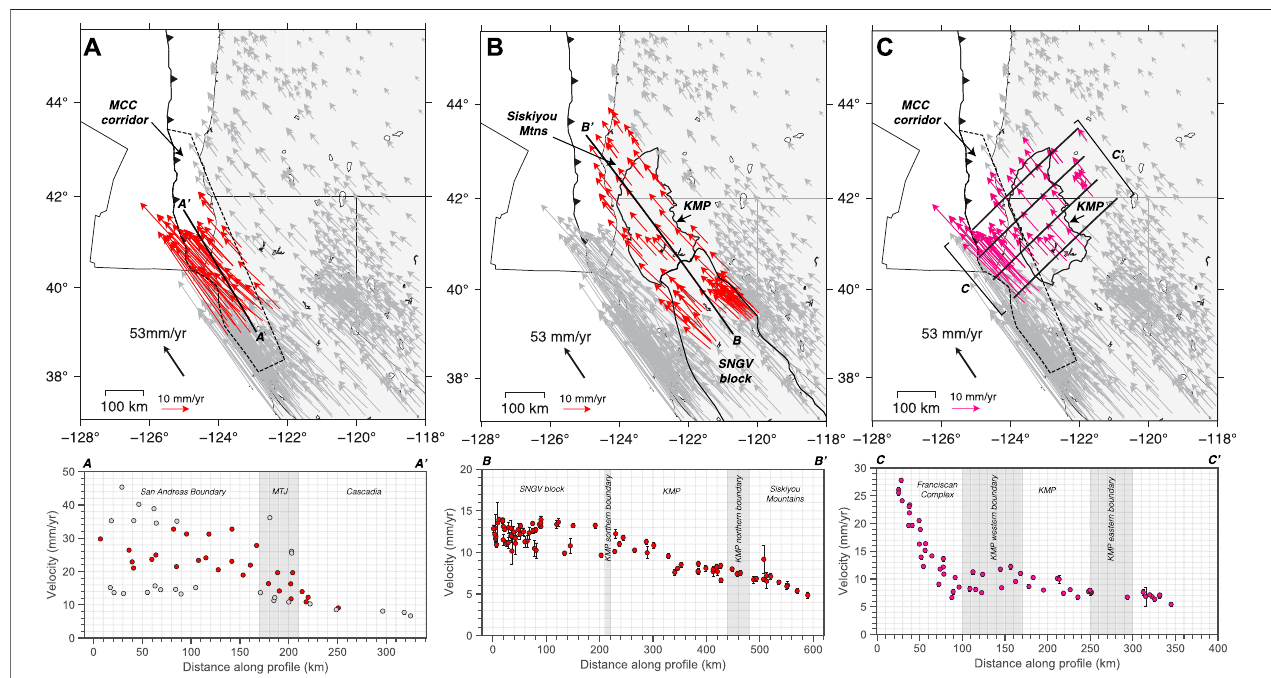
FIGURE5| Transectsthroughthepresent-dayNNW-directedandsubduction-relatedGPSdecomposedvelocity fi elds. (A) NNWtransect(southtonorth)through the NNW-directed velocity fi eldwithin theMCC corridor – theFranciscan complexwestofthe KMP.Red vectors withinthe map (top)are thevelocities(bothgrey and red circles) shown in the pro fi le (bottom). The grey circles are vectors over 25 km from the pro fi le line. (B) NNW transect (south to north) through the NNW-directed velocity fi eld within the KMP. Red vectors within the map (top) are the velocities (red circles) shown in the pro fi le (bottom). (C) NE transect (west to east) through the NNW- directed velocity fi eld through the MCC corridor and the KMP. Pink vectors within the map (top) are the velocities (pink circles) shown in the pro fi le (bottom).